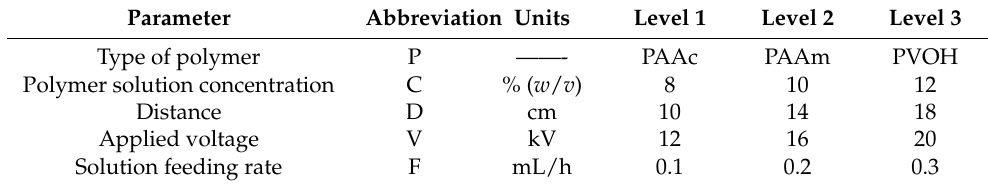
Table 1. Experimental parameters and their levels.